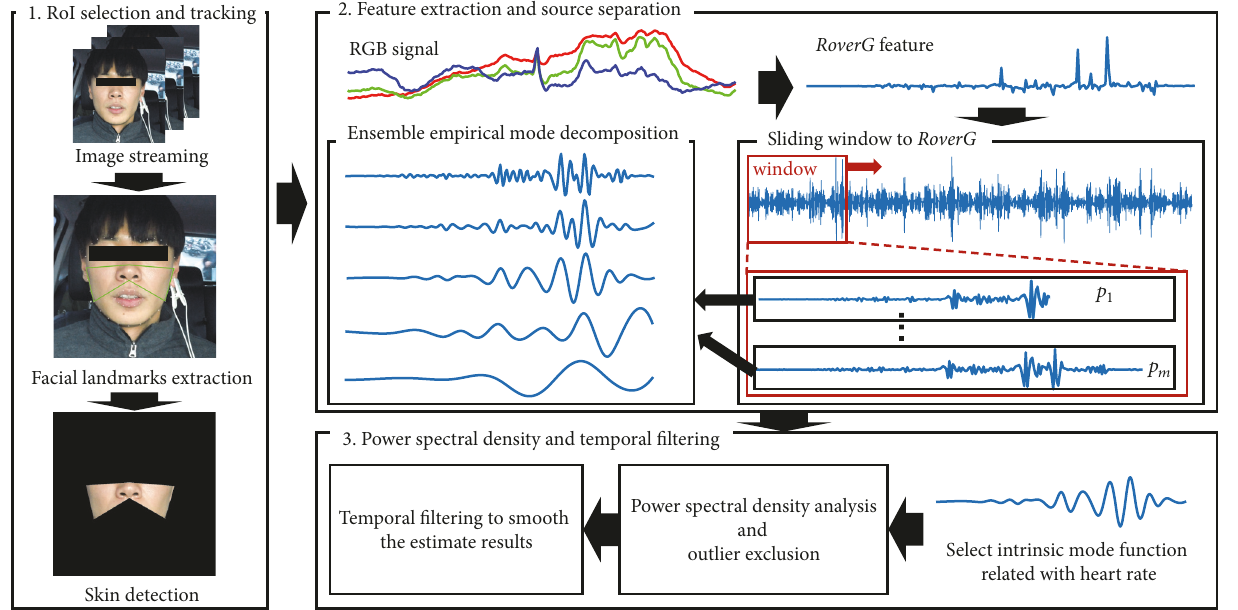
Figure 1: Conceptual overview of the proposed heart rate estimation method under driving environment.